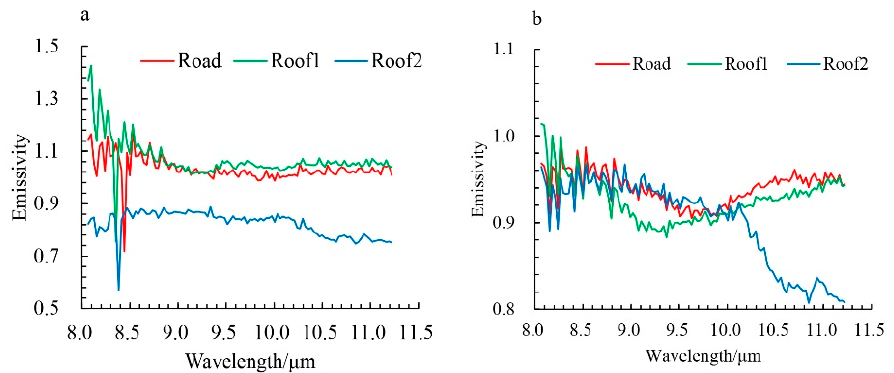
Figure 11. The retrieved emissivity spectrum based on the data before ( a ) and after ( b ) blind pixel repair.